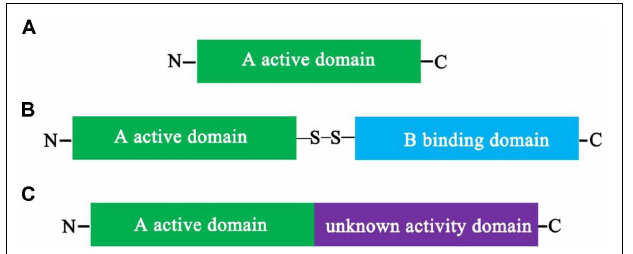
FIGURE 1 | Schematic depiction of the structure of plant ribosome-inactivating proteins (RIPs). Schematic representation of the mature forms of Type I (A) , Type II, (B) and Type III (C) plant RIPs. Comparison between the mature forms of a Type I (RIP) (A) , such as α -MMC, composed only of a catalytically active A domain, and that of a Type II RIP (B) , such as ricin, in which the active domain is linked to a lectin-binding B domain by a disulfide bond, and that of a Type III RIP (C) , such as barley JIP60, in which the active domain is fused to an extra domain with an unknown